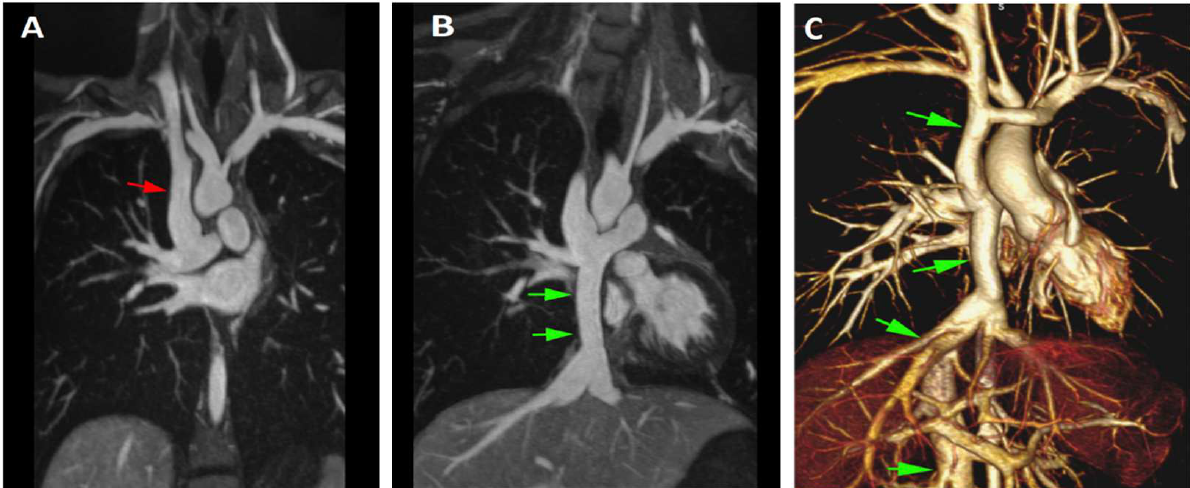
Figure 3. Fontan Circulation. Breath-held and ECG-gated FE-MRA in an adult patient with single ventricle heart disease who has undergone Fontan surgical palliation (i.e., routing of the SVC and IVC to the branch pulmonary arteries). Panel ( A ): Coronal maximum intensity projection depicting the superior limb (Glenn shunt) of the systemic venous drainage (red arrow). Panel ( B ): Coronal maximum intensity projection in a more posterior position from that in Panel ( A ) showing the inferior limb (Fontan conduit) of the systemic venous drainage and its connection to the right branch pulmonary artery (green arrows). Panel ( C ): 3D volume rendered image the image dataset which clearly and homogenously depicts the Fontan circulation (green arrows). The entire gated volumetric acquisition was acquired in a single breath-hold.